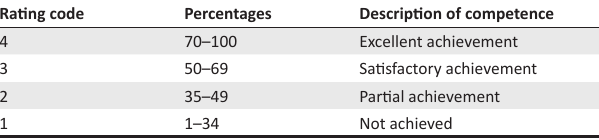
TABLE 2: Department of Education national coding system’s progression schedule for Grades 1–3. Rating code